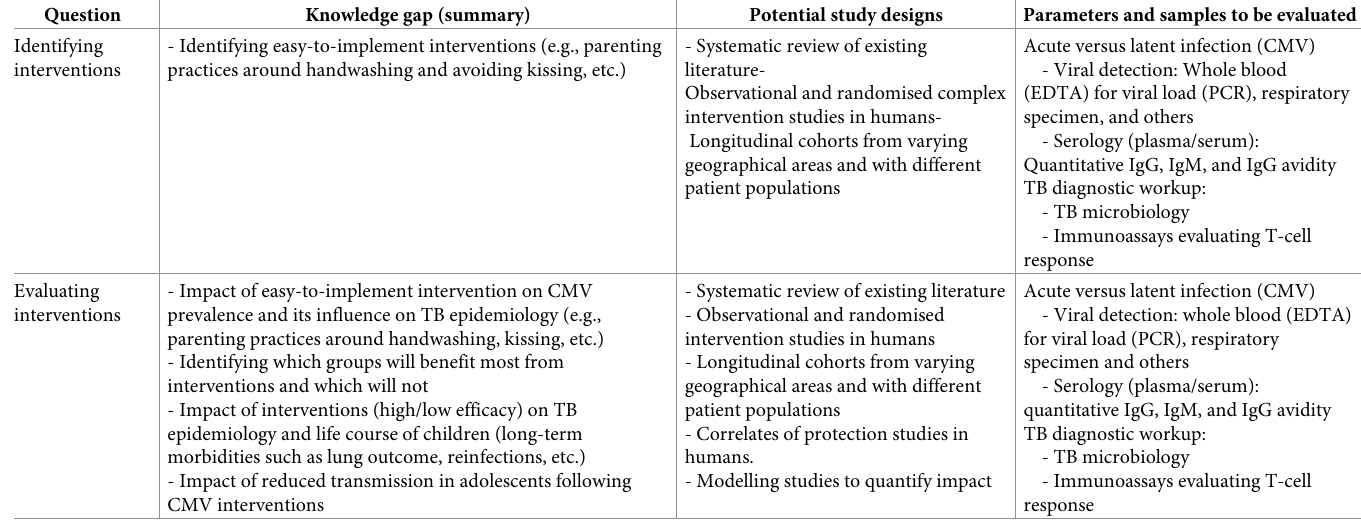
Table 5. Interventions that might reduce the impact of CMV on TB progression from infection to